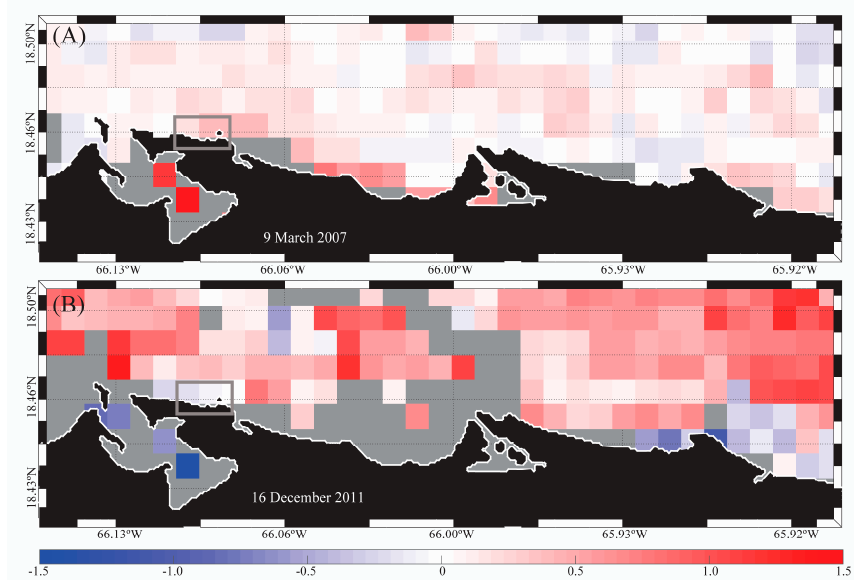
Figure 4. Sea Surface Temperature (SST) anomalies (from the Advanced Very High Resolution Radiometer-AVHRR; 1km spatial resolution) showing Escambron Beach (gray box) three days before the beach advisories of ( A ) 9 March 2007; and ( B ) 16 December 2011.